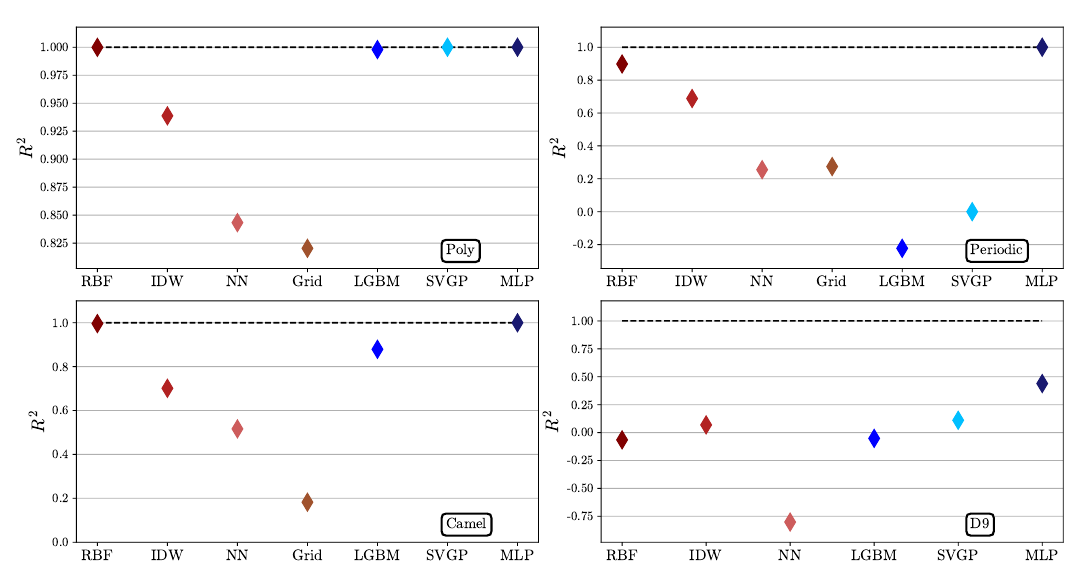
Figure 13: R 2 values in 9 dimensions for the three toy functions and D9.